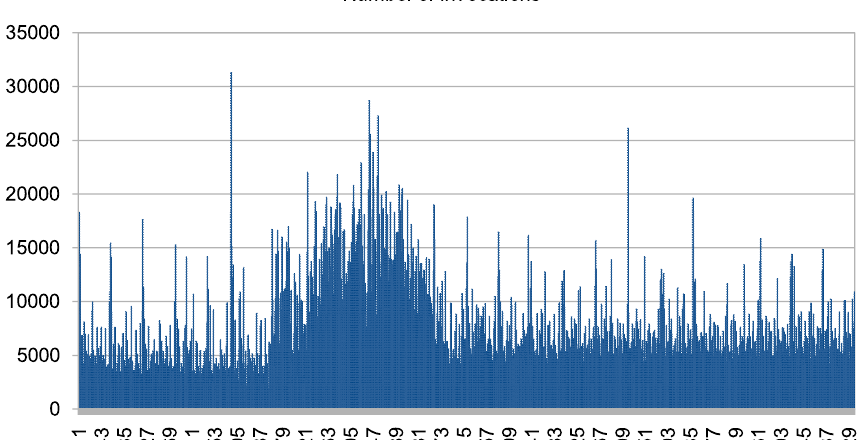
Fig. 4 Number of orchestration trigger invoked during one